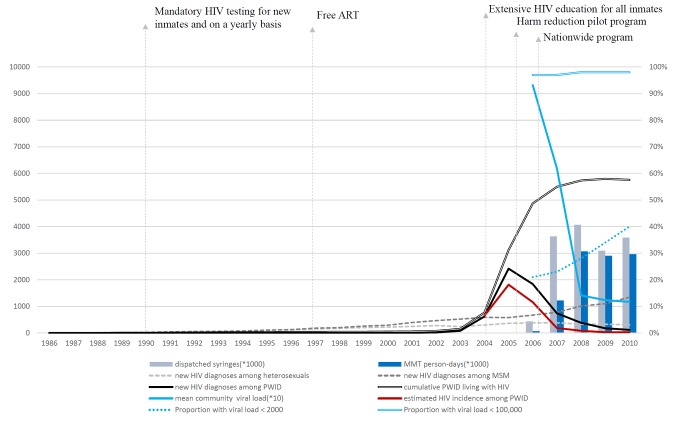
The temporal trend in HIV incidence among PWID and distribution of harm reduction services.Annual number of dispatched syringes is the total number of clean needles/syringes purchased by the CDC. The number of MMT person-days was calculated from personal records from the national methadone management system. Data on the number of new HIV diagnoses via different transmission routes, the cumulative number of PWID living with HIV, and community viral load were from the national HIV/AIDS reporting system. The estimated HIV incidence among PWID was from tested sera from 3,851 prisoners who were incarcerated because of illicit drug use who were diagnosed with HIV between 2004 and 2010; the sera were tested using a modified BED assay to estimate HIV incidence. Viral load values are copies/milliliter. MSM, men who have sex with men.